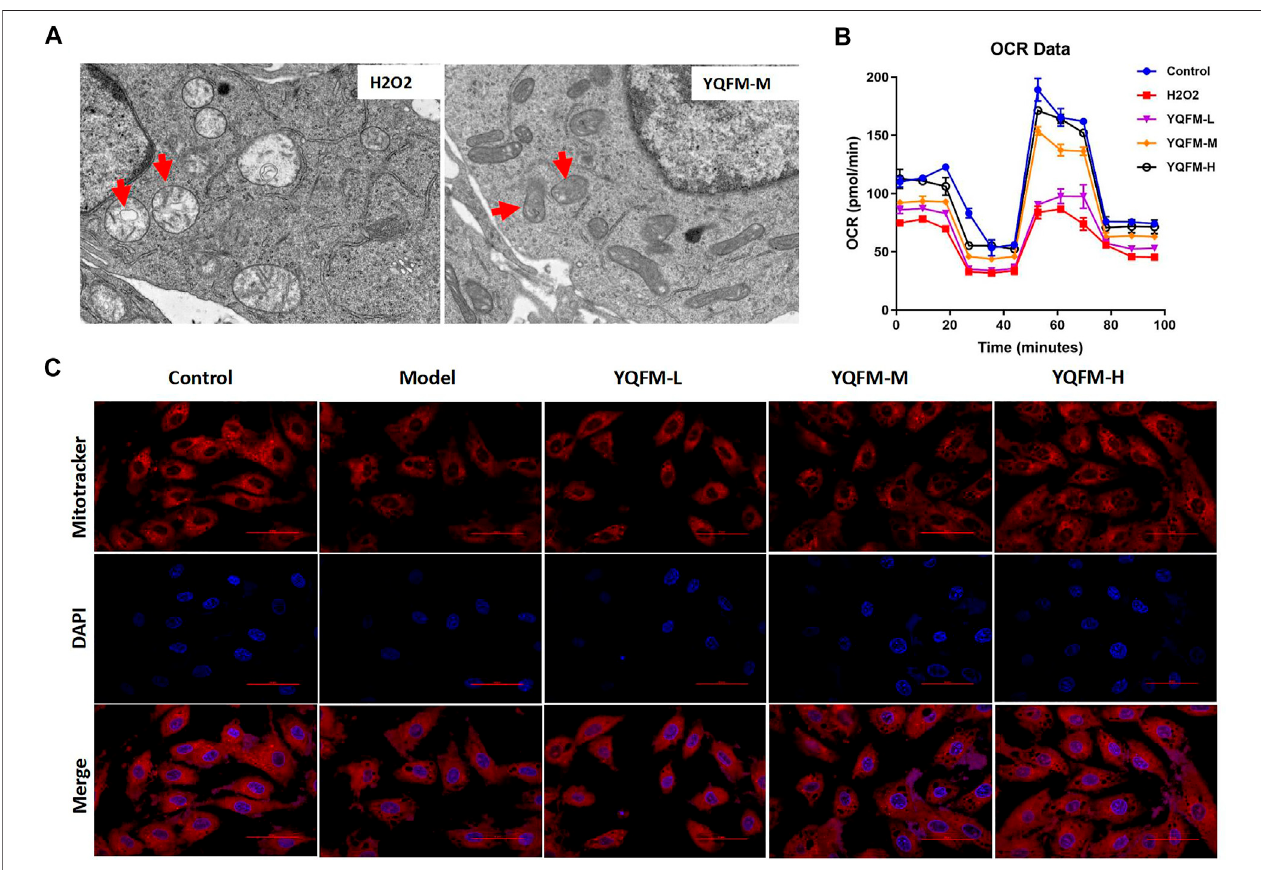
FIGURE 9 | YQFM ameliorated the mitochondrial dysfunction induced by H 2 O 2 in vitro . (A) TEM images of the ultrastructural morphology of H 9 C 2 cells mitochondria. (B) Oxygen consumption rates (OCR) in H 9 C 2 cells treated with YQFM-L, YQFM-M& YQFM-H. (C) H 9 C 2 cells were subjected to Mitotracker red staining. The model group refers to H 9 C 2 cells induced by H 2 O 2